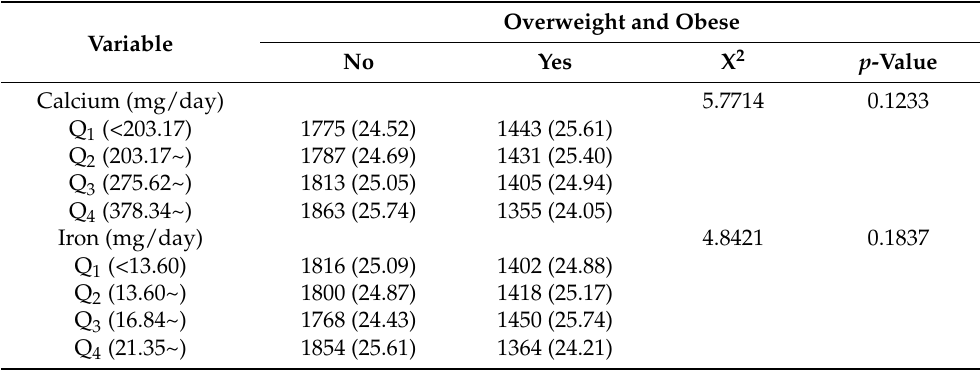
Table 4. Univariate analysis of the effect of dietary mineral intake on overweight/obesity in non- pregnant and non-lactating women aged 18–49